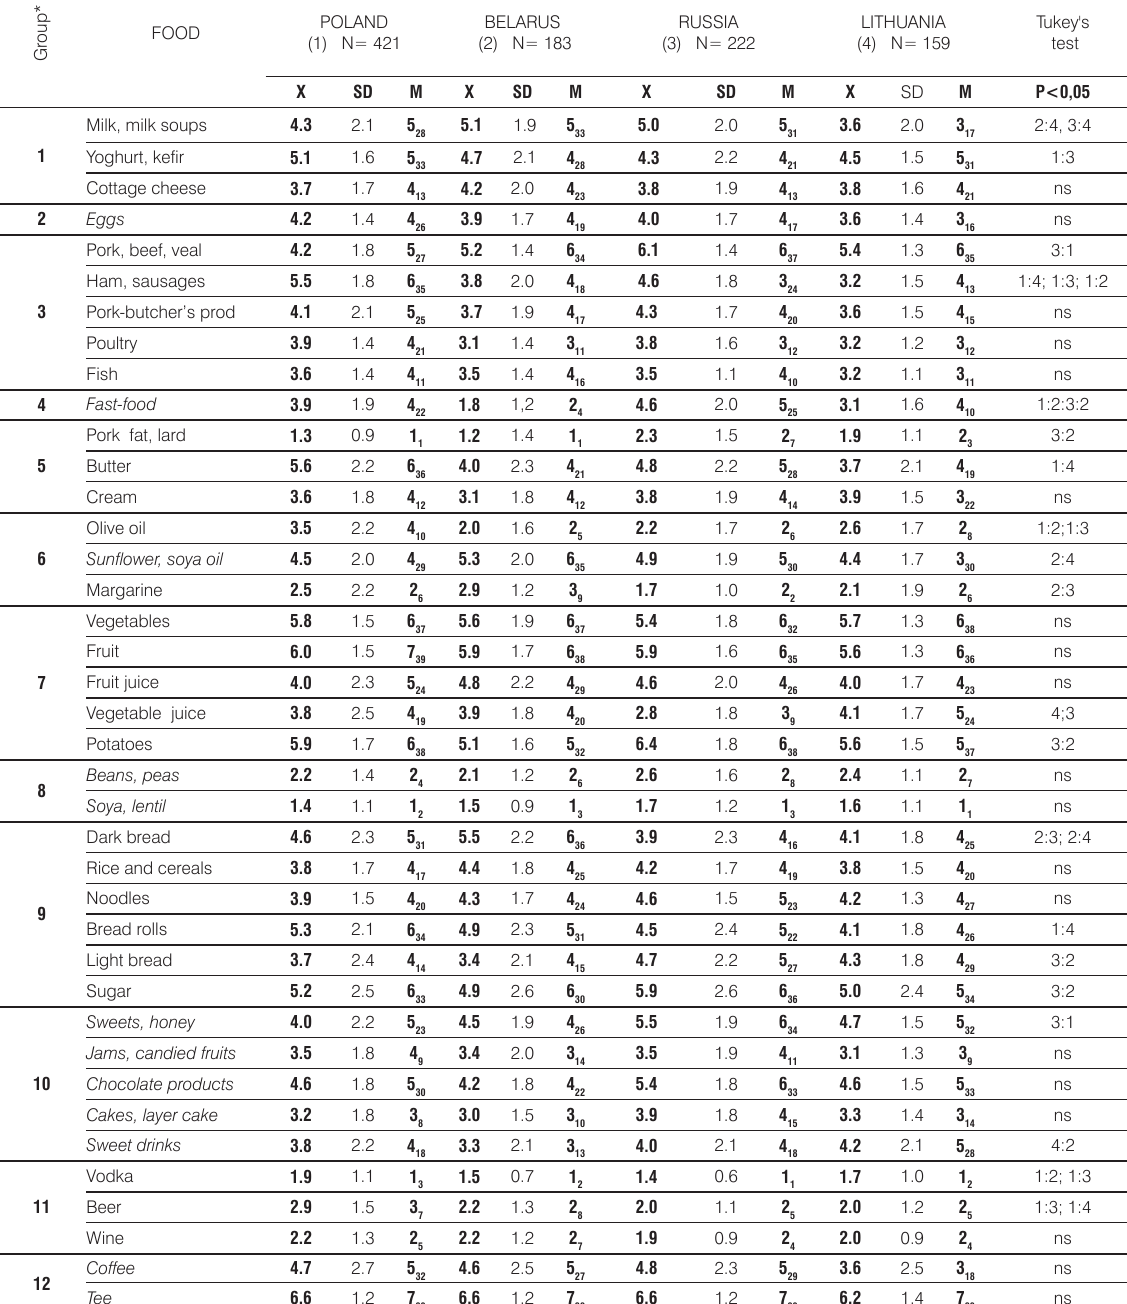
Table 4. The consumption frequency of examined food products in the group of